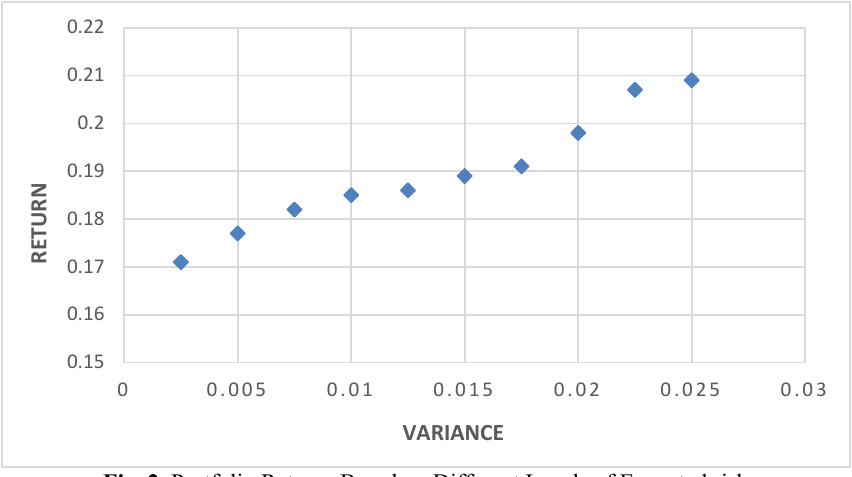
Fig. 2. Portfolio Returns Based on Different Levels of Expected